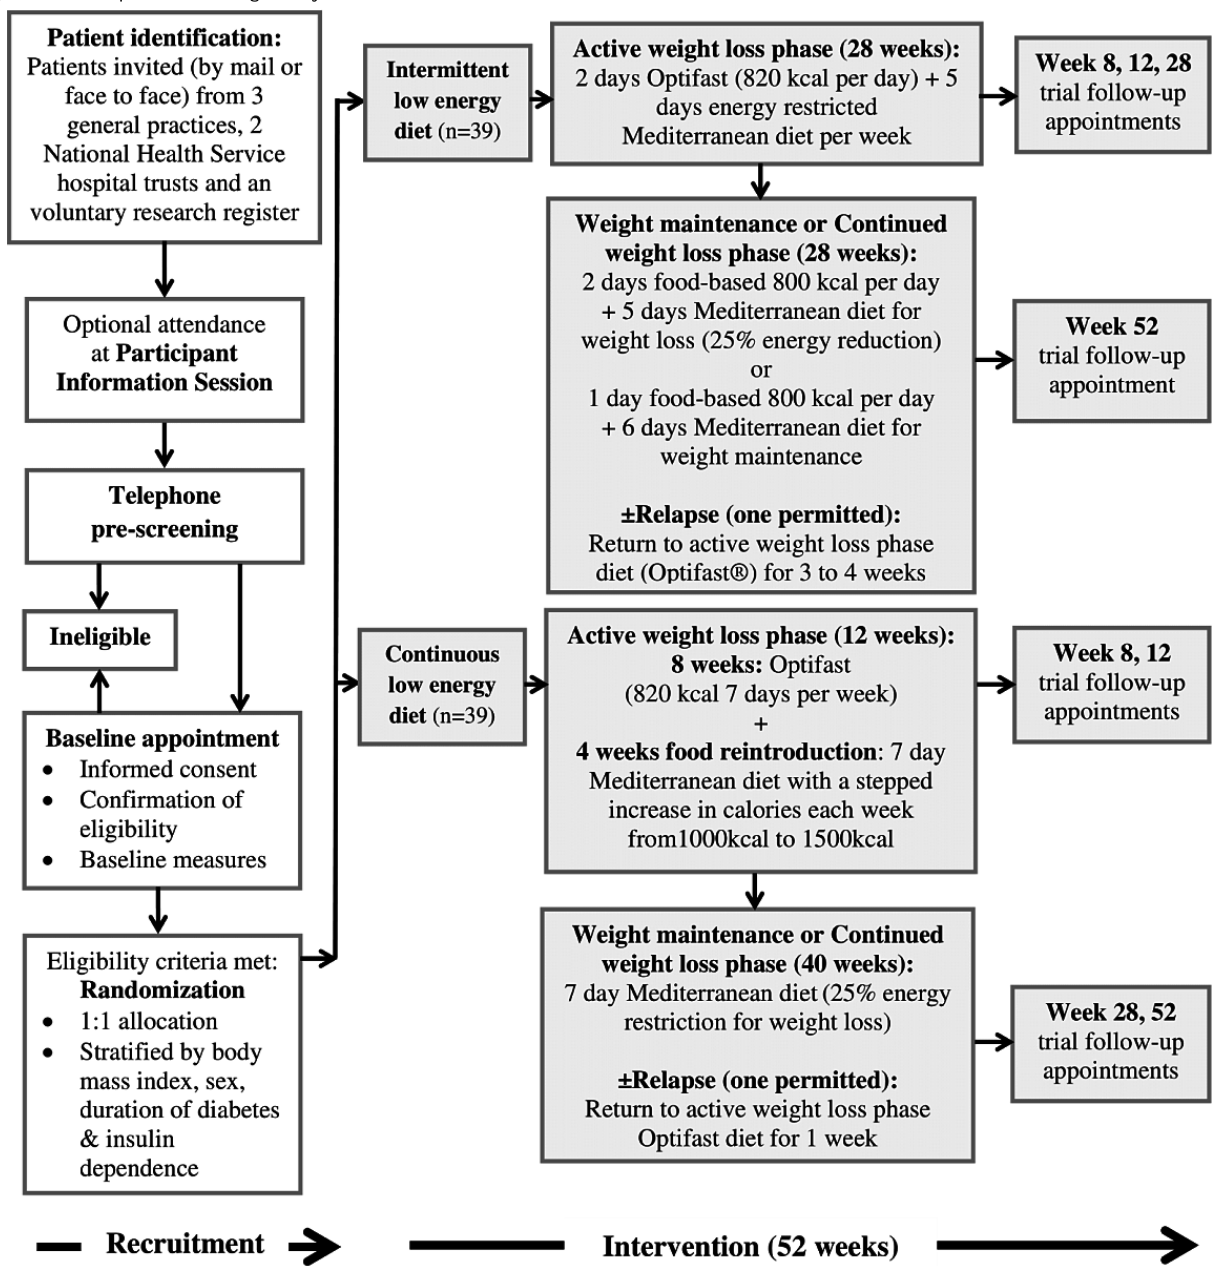
Figure 1. Participant flow through